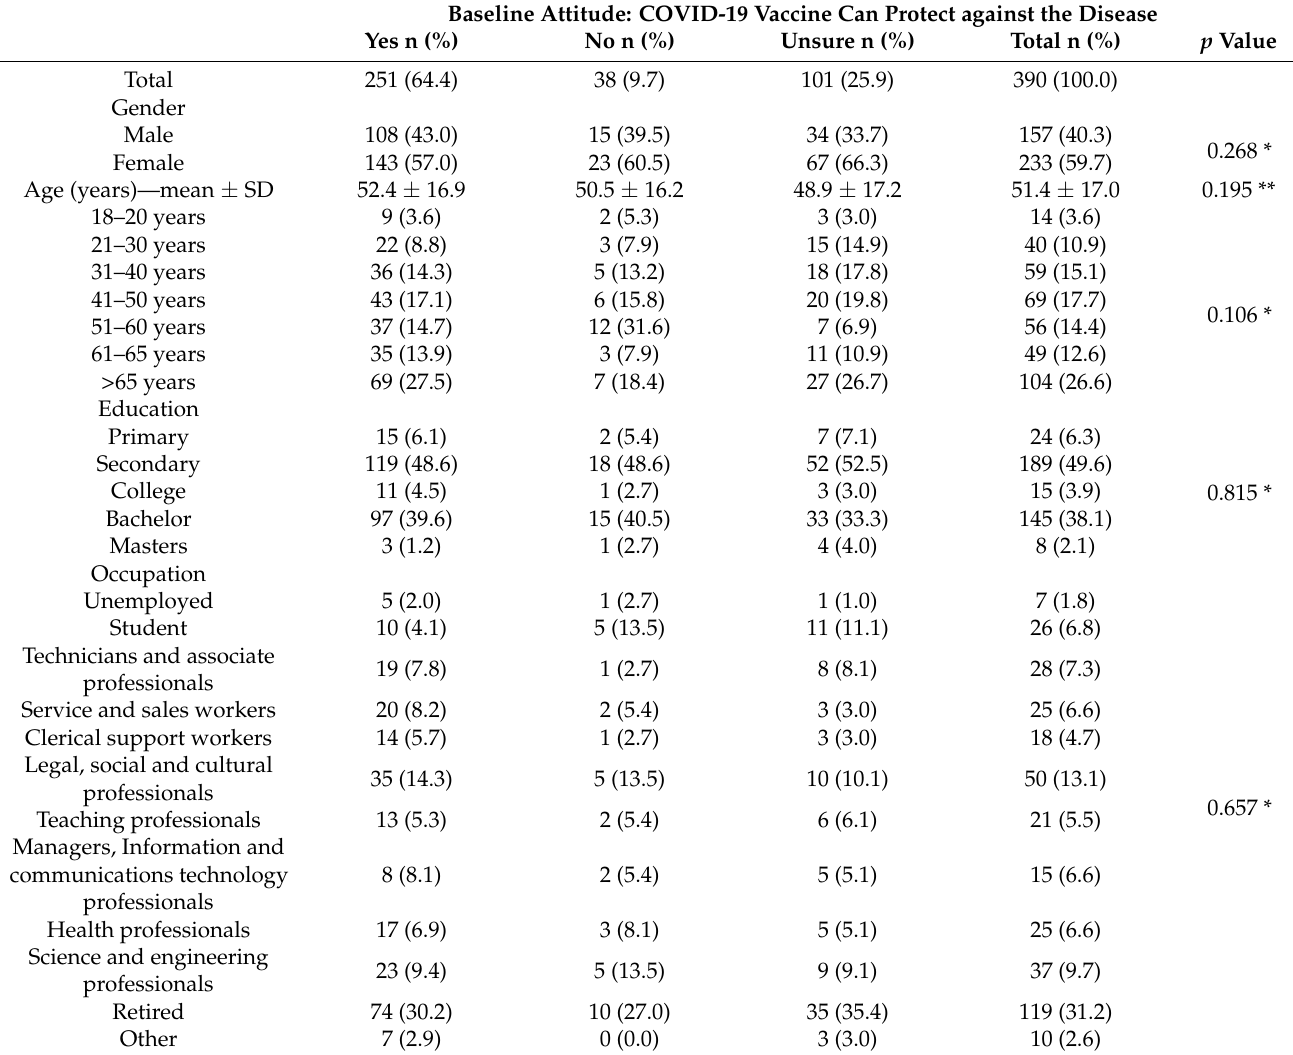
Table 1. Demographic characteristics of participants based on COVID-19 vaccine protection